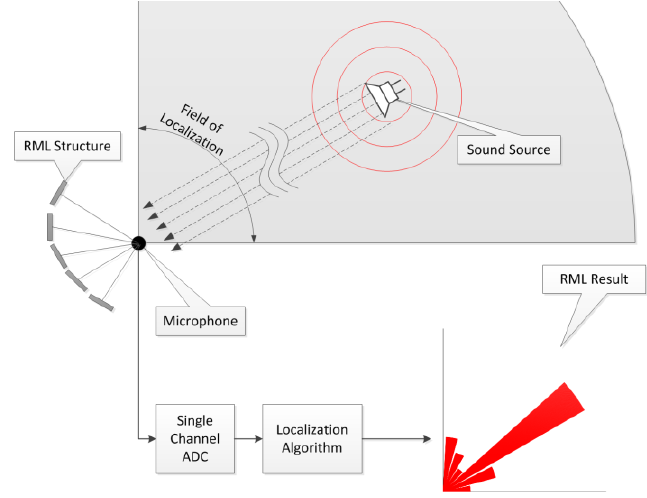
Figure 1. Functional diagram of the reflective monaural localization (RML) system.